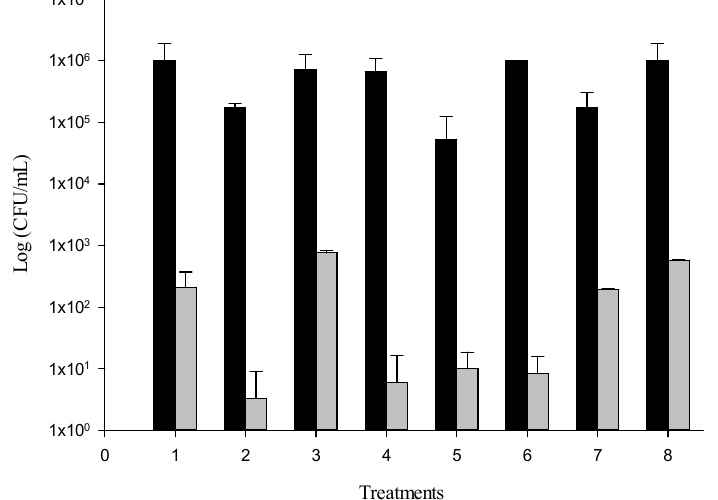
Figure 2. Bacterial load of the effluent water circulated through non-modified cork (control, black bars) and through the f -cork (grey bars) in the eight treatments. The initial E. coli count for the contaminated water was ~1 x 10 8 CFU/mL.